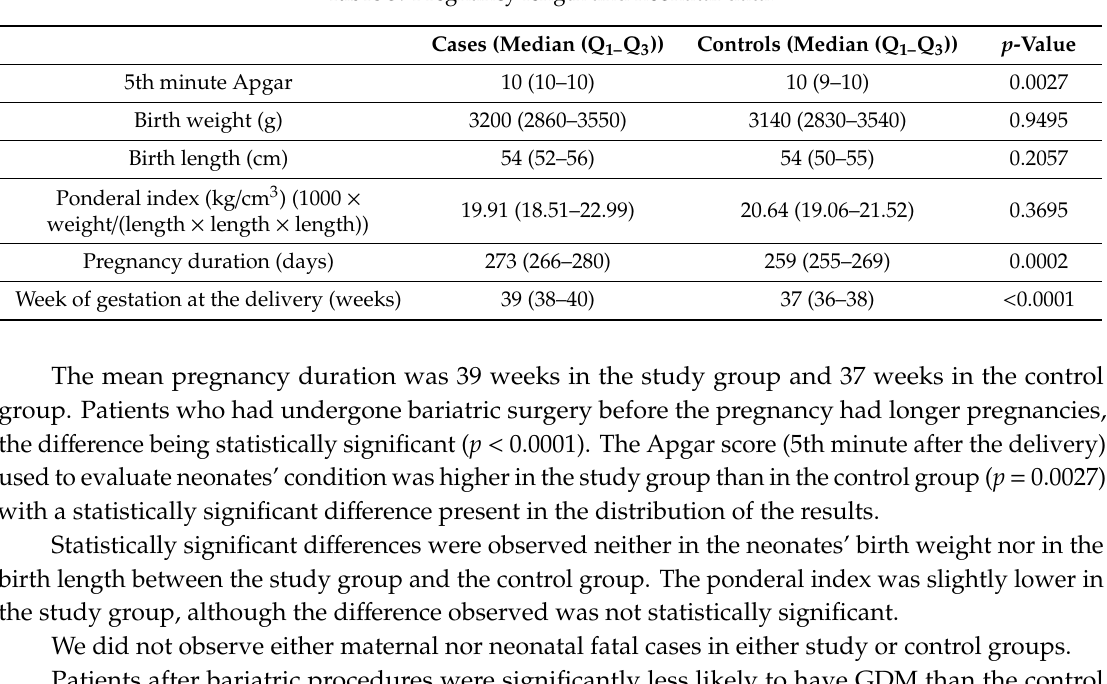
Table 3. Pregnancy length and neonatal